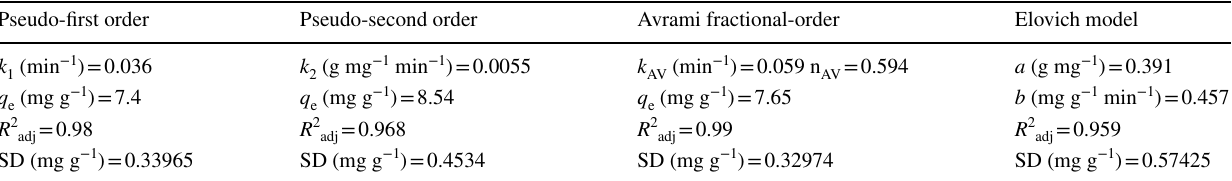
−1 ) 3 O 4 NPs (1 mg mL